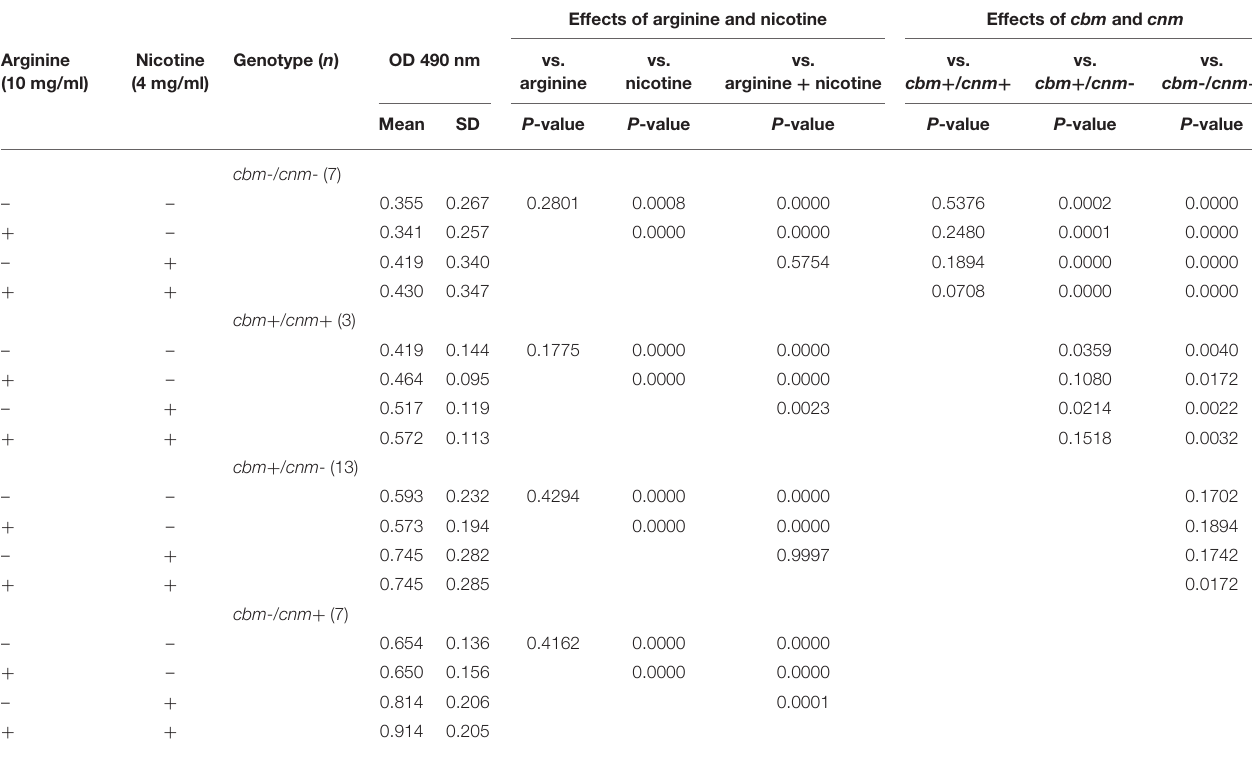
TABLE 3 | The effects of S. mutans CBP genotype on biofilm metabolic activity in response to arginine (10 mg/ml) and nicotine (4